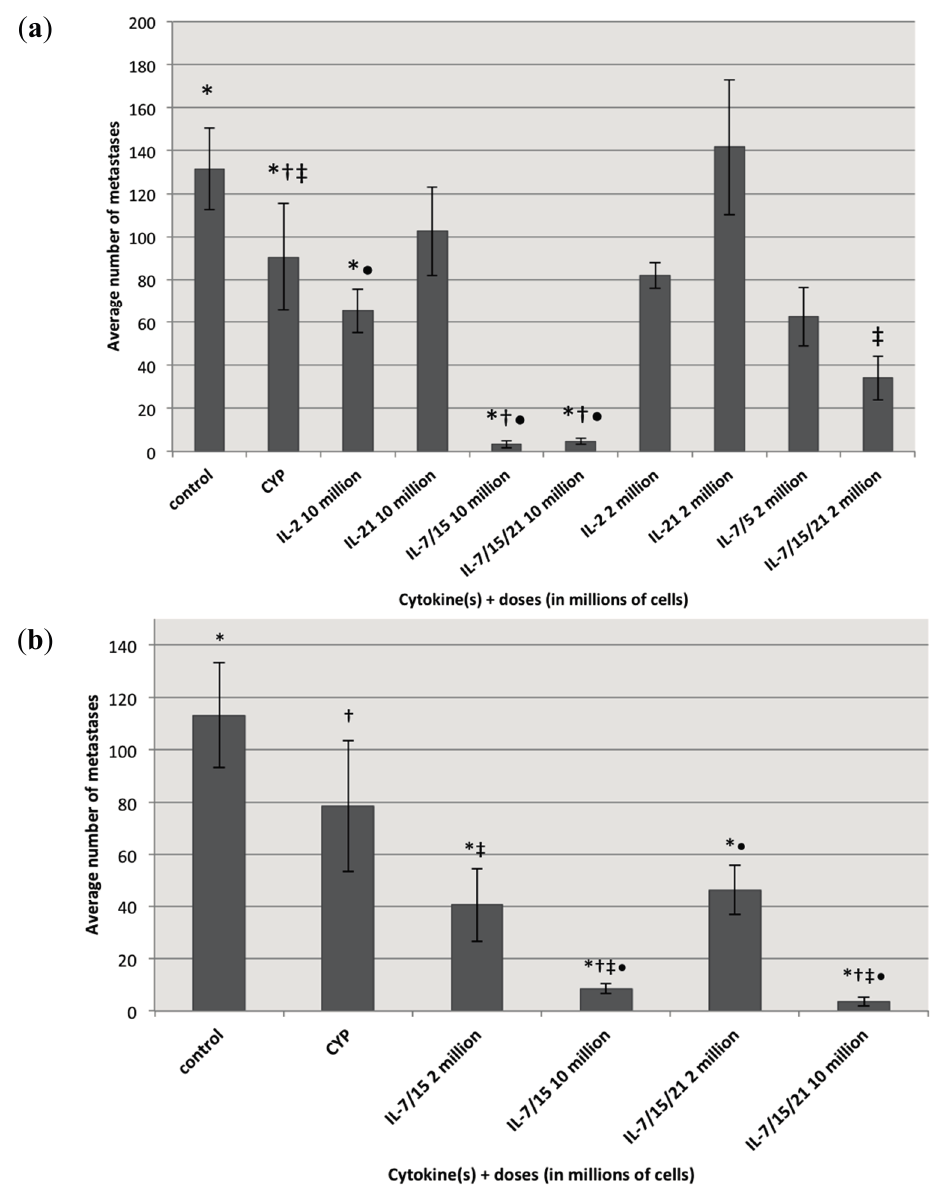
Figure 6. Average number of metastases in untreated mice, mice treated with cyclophosphamide (CYP) only and mice treated with cyclophosphamide and adoptive immunotherapy (AIT) with doses of either 10 million or 2 million spleen-derived T cells ( a ) activated with B/I and cultured for seven days in IL-2, IL-21, IL-7/15 or IL-7/15/21, * ( vs